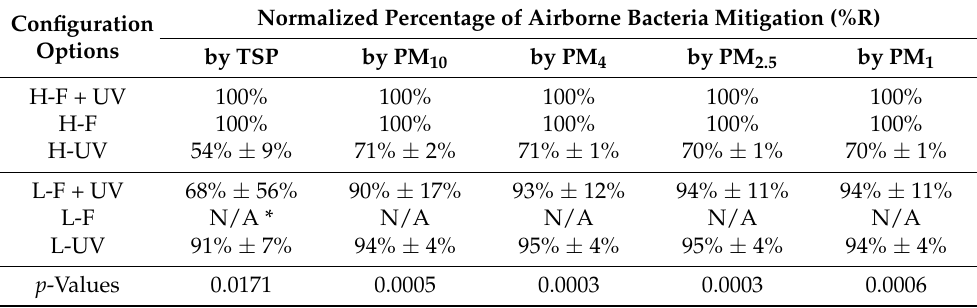
Table 4. The percentage removal of viable airborne bacteria is normalized by different PM sizes. Configuration